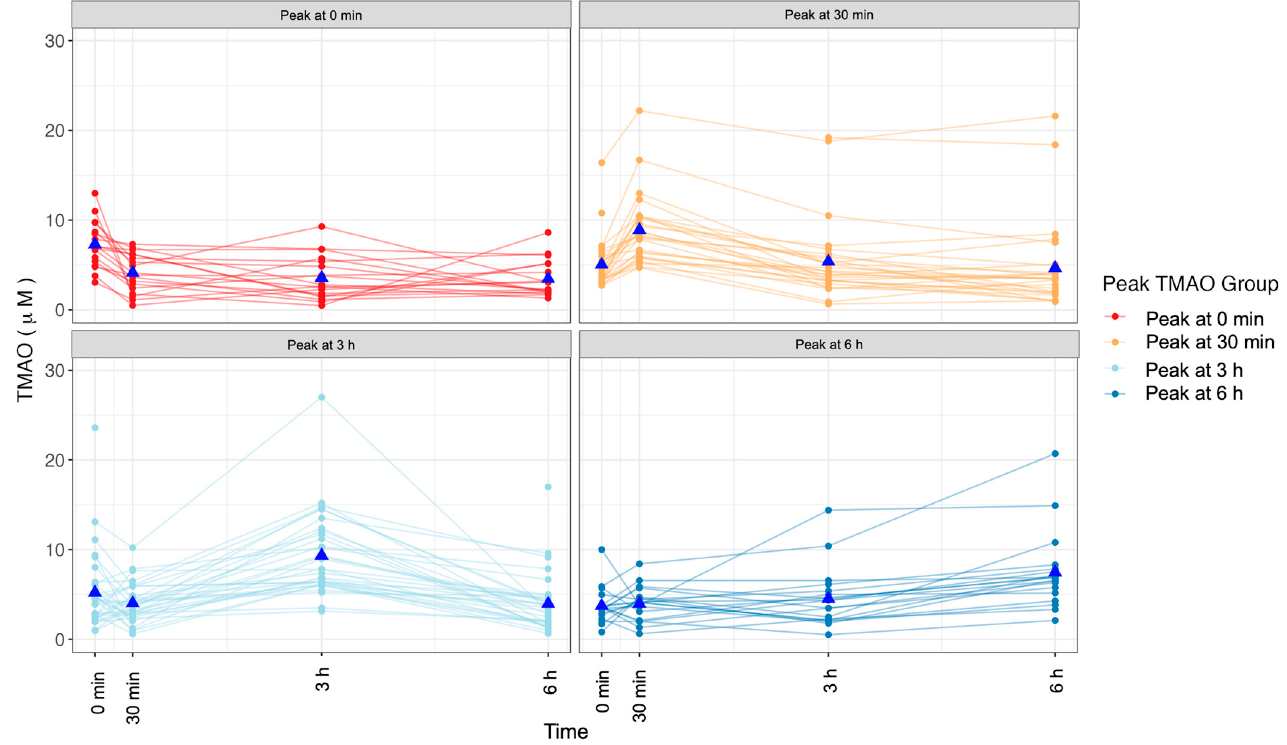
Figure 3. Postprandial TMAO concentrations are individualized. Variation in postprandial TMAO concentration was observed amongst participants. Participants were grouped by the timepoint (0 min, 30 min, 3 h, or 6 h) at which they experienced their maximal plasma TMAO concentration. Maximal TMAO concentrations were observed at each timepoint resulting in four TMAO-response groups. Each line represents an individual’s metabolic response. The blue triangles represent the group’s mean. Table 3 . Plasma TMAO concentrations by TMAO-response group. Plasma TMAO concentrations (µM) at 0 min, 30 min, 3 h, and 6 h in individuals grouped by their TMAO response to an MMTT without choline, carnitine, or betaine.